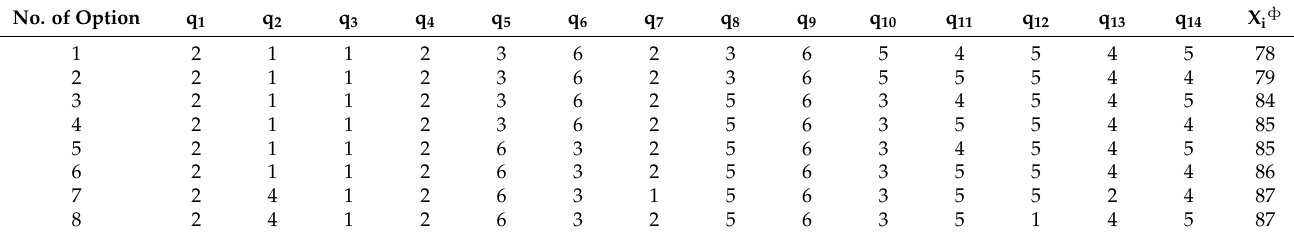
Table 7. Options for redistributing functions to project teams after redistribution.